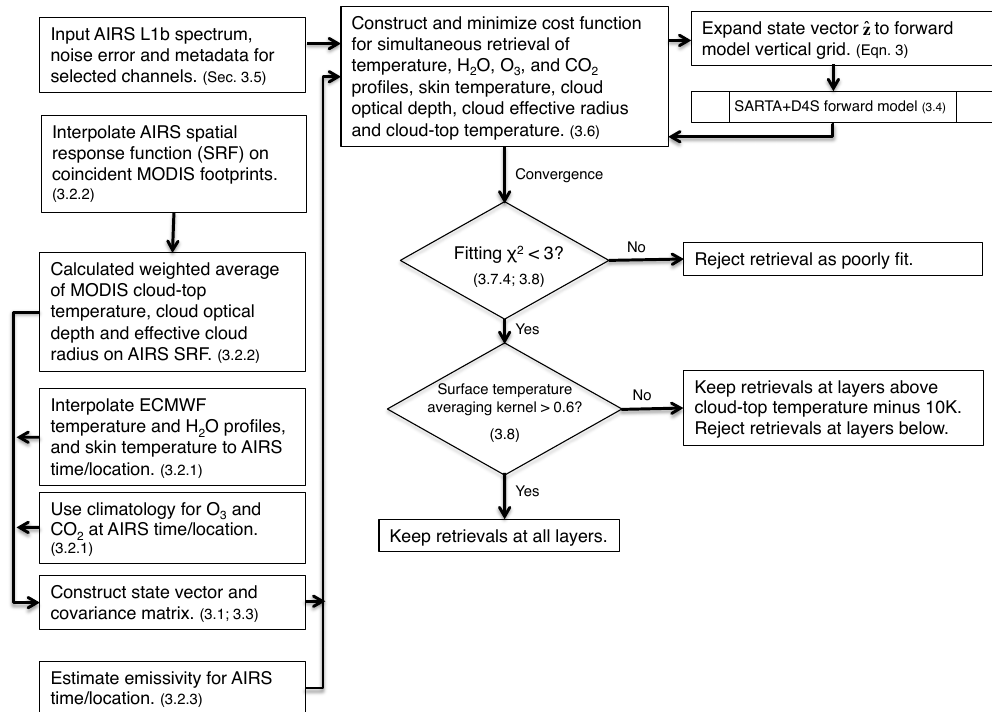
Figure 2. Simplified block diagram of AIRS-OE retrieval algorithm for cloudy scenes. Blocks are annotated with section numbers from this paper for further